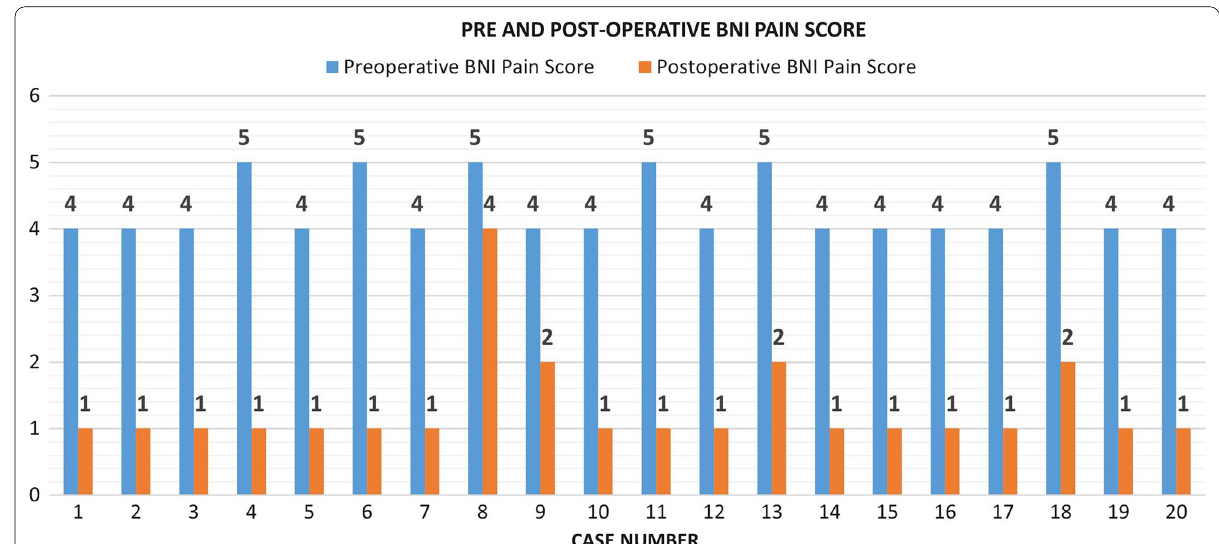
Fig. 6 Pre- and postoperative outcome using the Barrow Neurological Institute (BNI) pain score